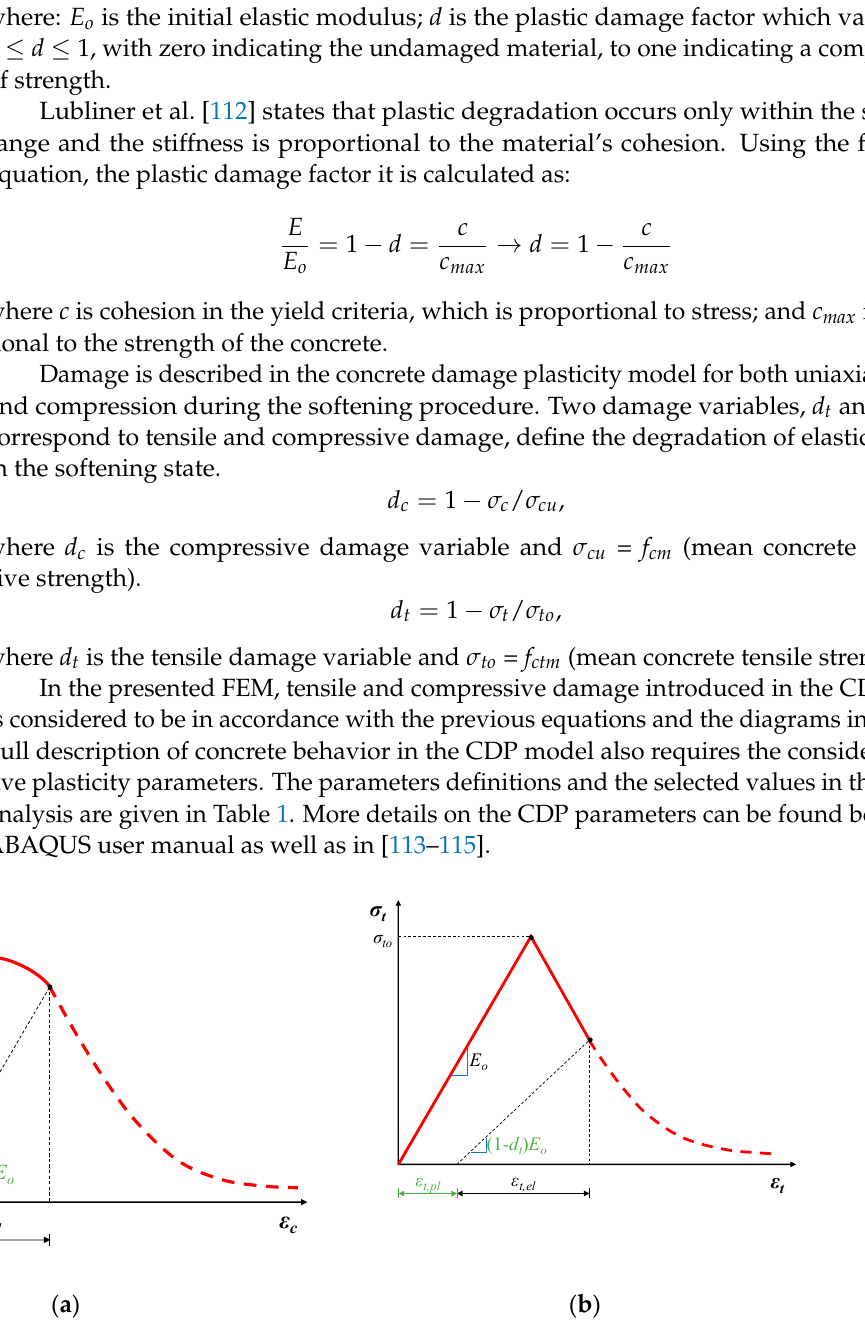
Figure 8. Definition of damage under ( a ) compression; ( b ) tension, where ε c,pl and ε t,pl are the equivalent plastic strains (considering damage) for compression and tension respectively and ε c,el and ε t,el are the elastic strains.